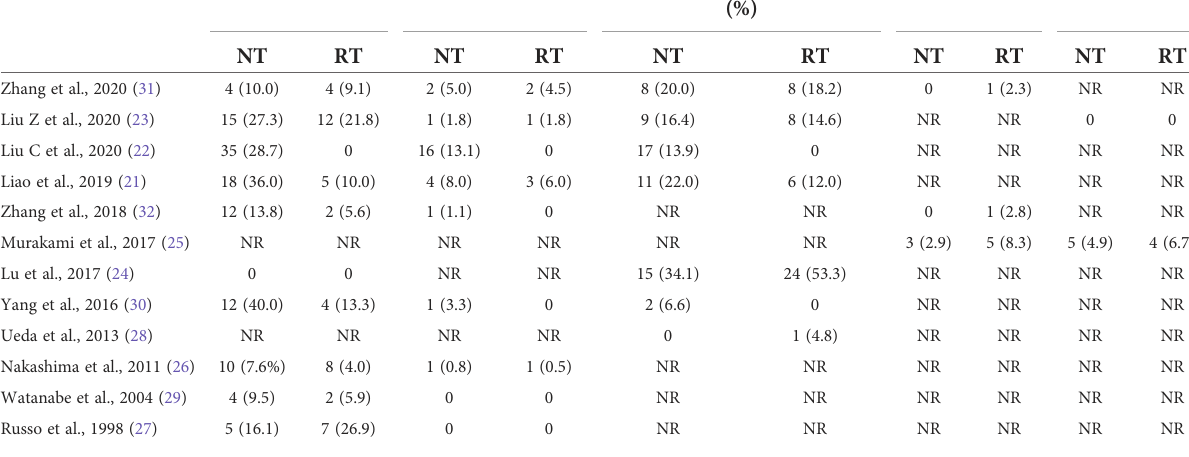
TABLE 3 Detailed postoperative complications of the included studies.